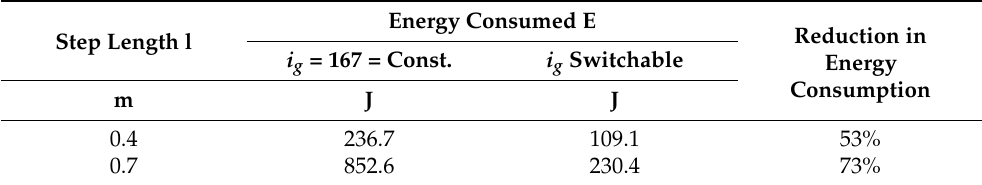
Table 1. Comparison of energy consumption by the robot systems operating with a constant versus a switchable gear ratio.